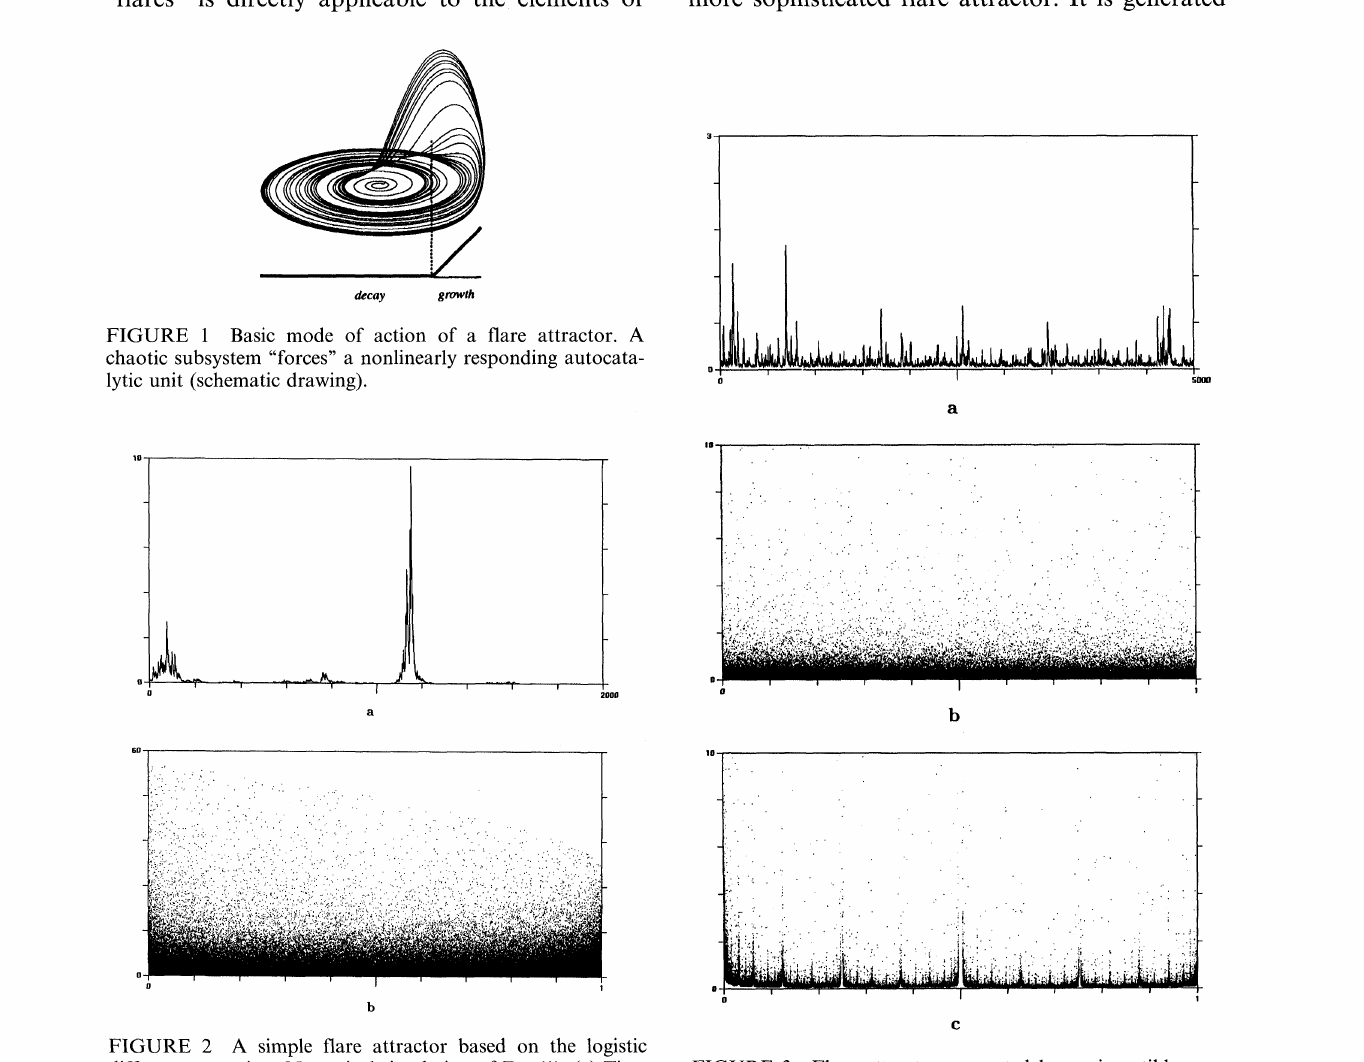
FIGURE 3 Flare attractor generated by an invertible map, Eq. (2). (a) Time behavior as in Fig. 2(a), but longer. (b) Side view (x,b plot) as in Fig. 2(b). (c) Cross-view (y,b plot). A cross section between x=0 and x is shown (note that no narrower slice is necessary with this particular map). 1000 000 iterations are shown (in (b) and (c)). Initial conditions: v, Y0 0.1, b0 0.1, tend 5000 (in x0